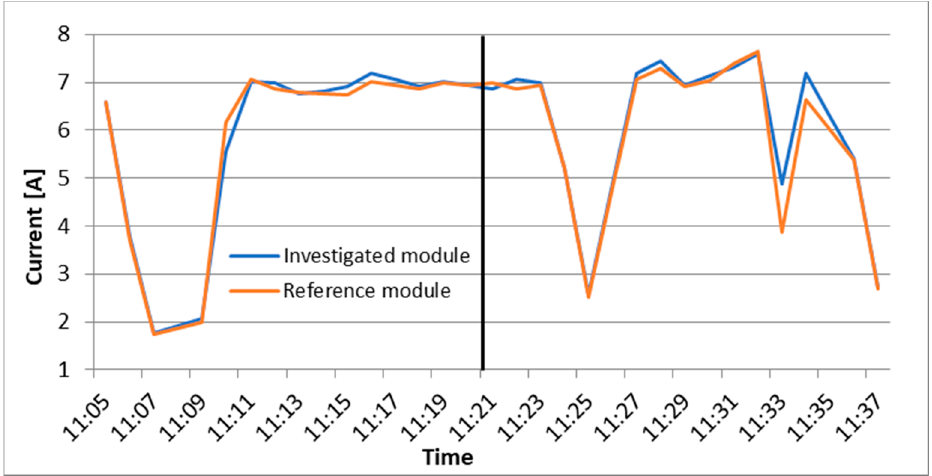
Figure 9. Current of investigated and reference modules during the comparative 30-min test.